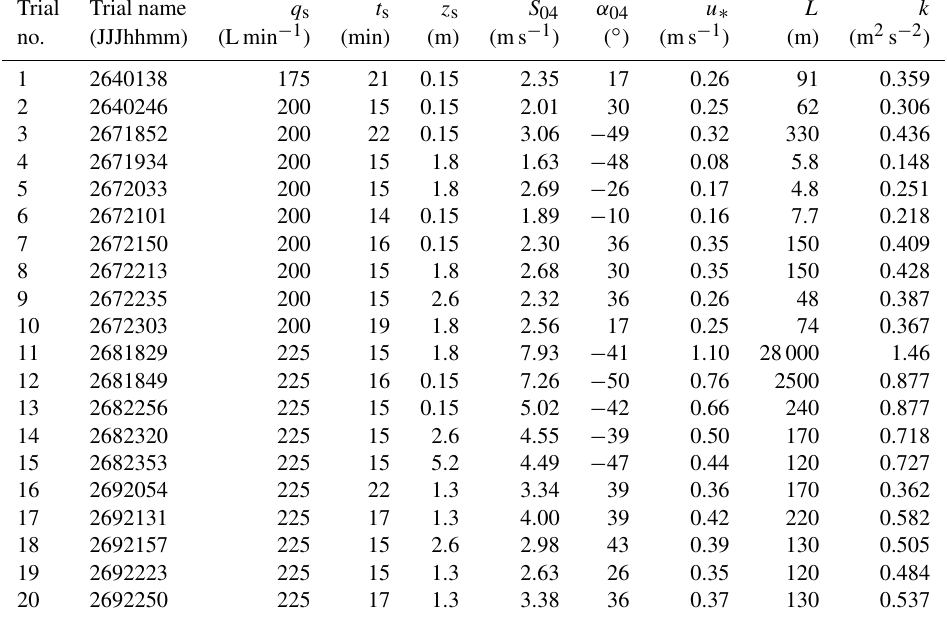
Table 1. The meteorological values (wind speed (S 04 ) , wind direction (α 04 ) at 4m level of mast S), turbulence (the Obukhov length (L) , friction velocity ( u ∗ ), turbulent kinetic energy (k) at 4m level of tower T), and source parameters (source height (z s ) , release duration (t s ) , release rate (q s ) ) in 20 selected trials of the MUST field experiment (Biltoft, 2001; Yee and Biltoft, 2004). Here, trial nos. 1–20 are assigned for continuation and simplicity, but these do not correspond to the same assigned trial number for a given trial name in the MUST